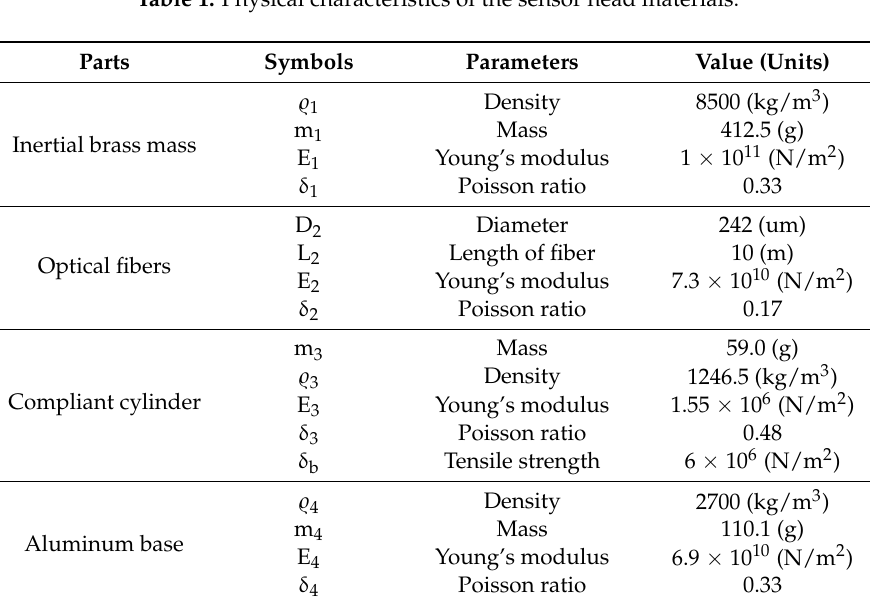
Figure 6. The structure of the compliant cylinder geophone. Table 1. Physical characteristics of the sensor head materials.